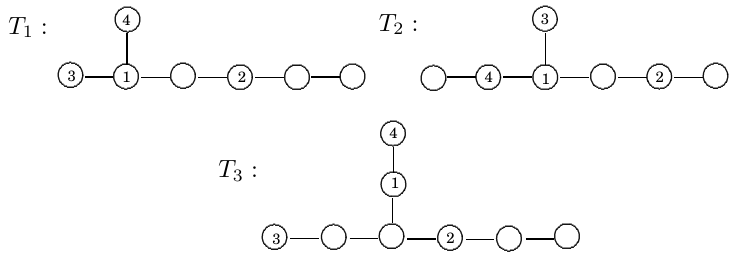
Figure 7: Three subtrees T